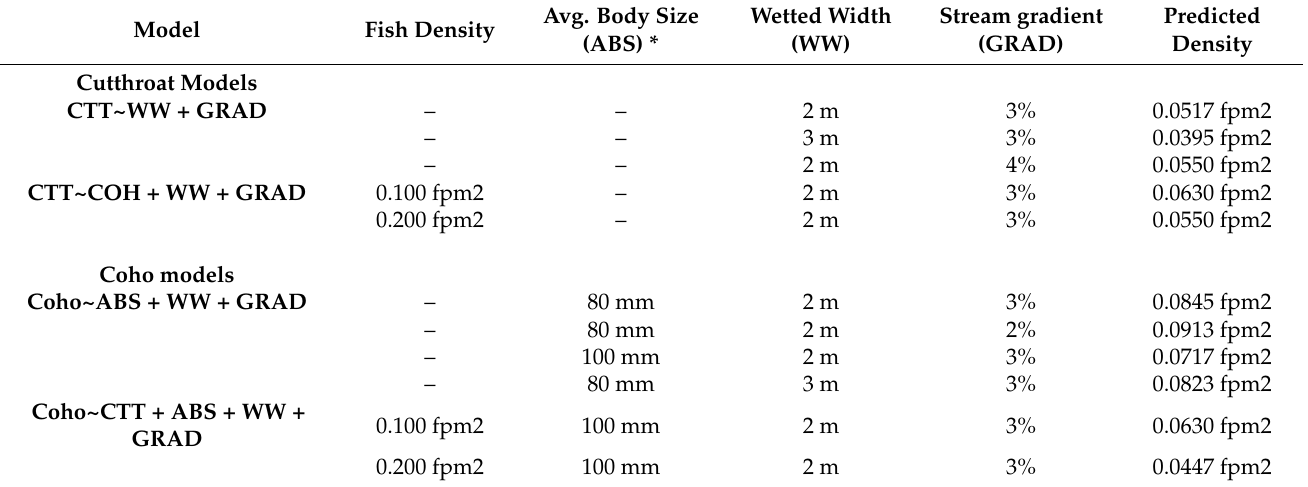
Table A1. Predicted fish densities for linear regression models. CTT = coastal cutthroat trout; Coho = coho salmo; fpm2 = fish per meter